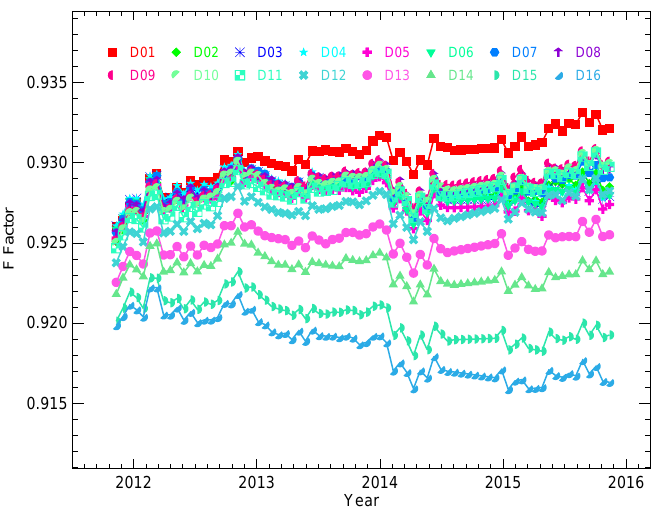
Figure 7. VIIRS band M4 HAM 1 HG SD F-factors.